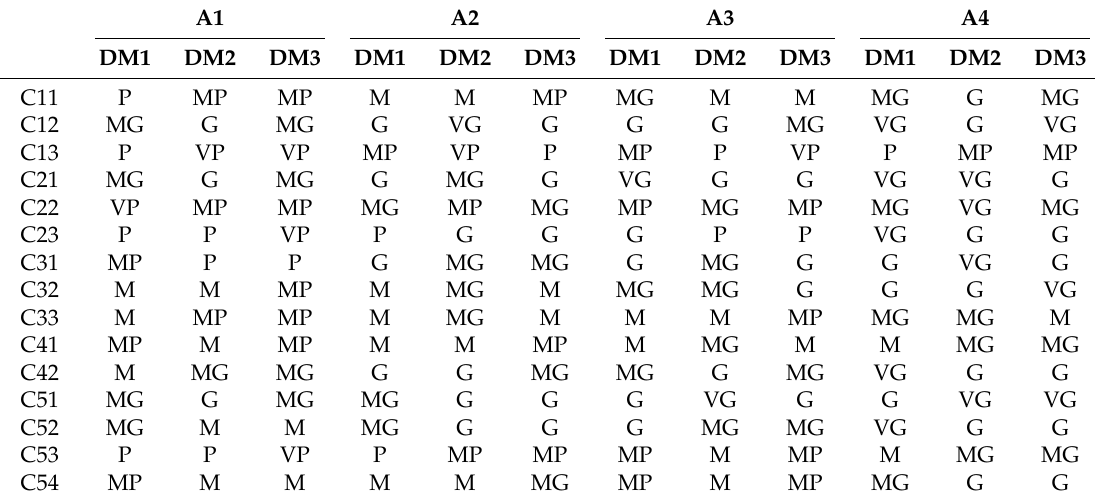
Table 6. Linguistic ratings for the sub-criteria of four site